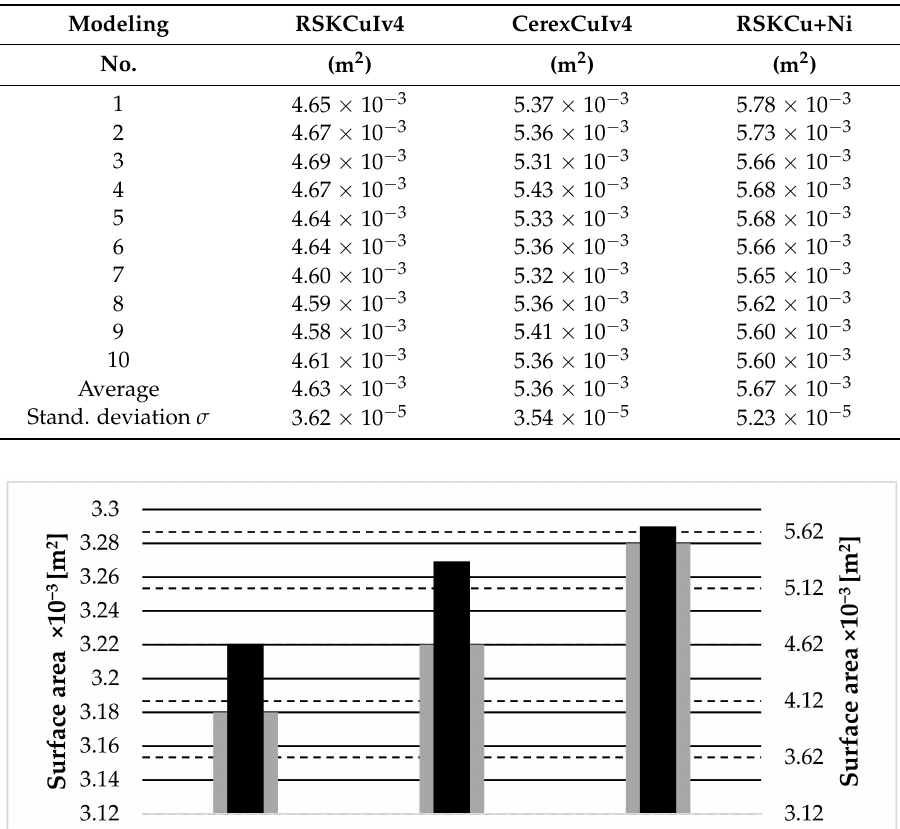
Table 15. The modeling results for surface area of samples.